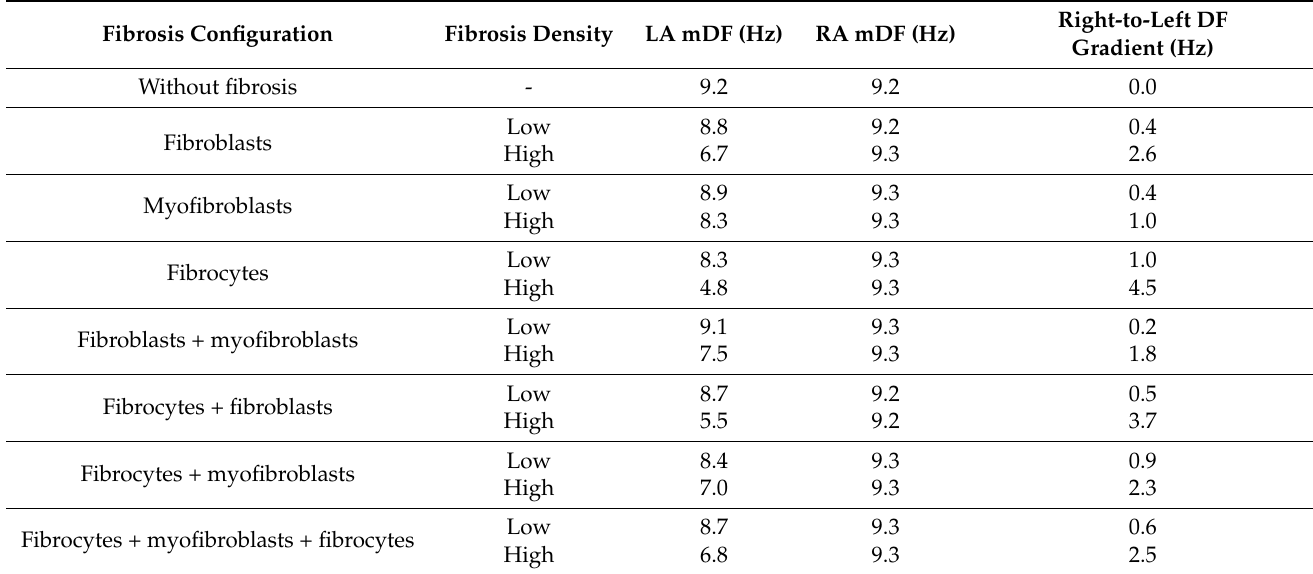
Right-to-Left DF Gradient (Hz)